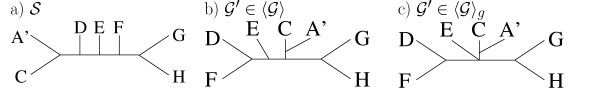
Modification of the supertree. The taxon set {A, B} is replaced by A'.